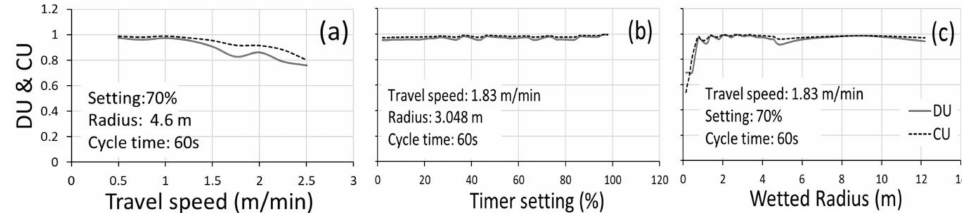
Figure 6. Distribution uniformity and coefficient of uniformity for the ellipse sprinkler pattern using different travel speed ( a ), percent timer setting ( b ), and wetted radius ( c ).